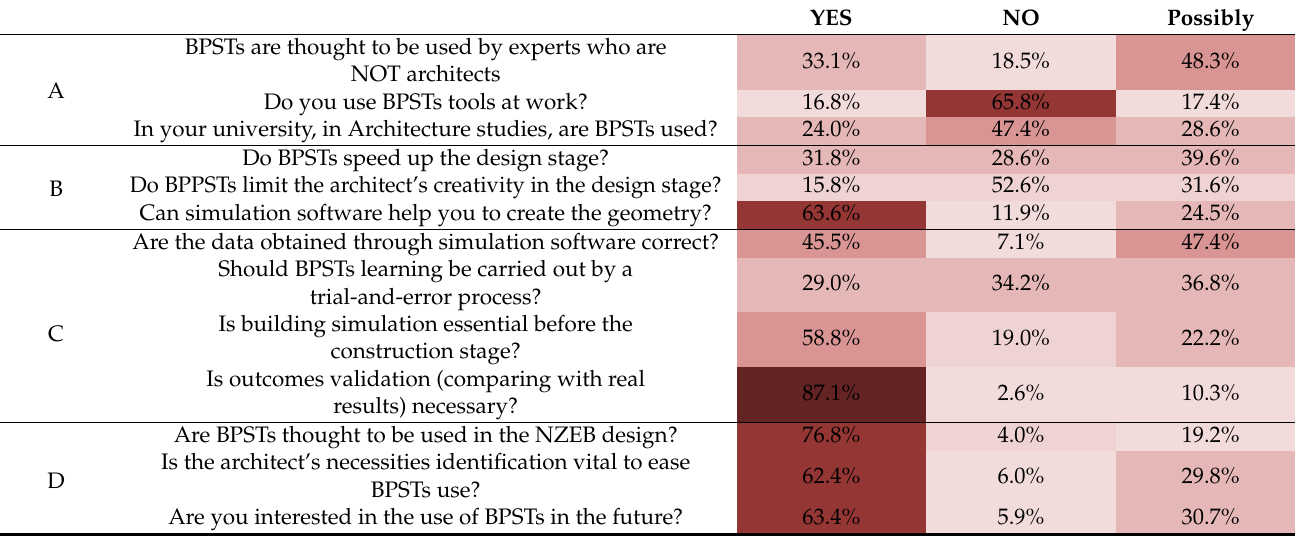
Table 1. Confidence parameters in the BPSTs .